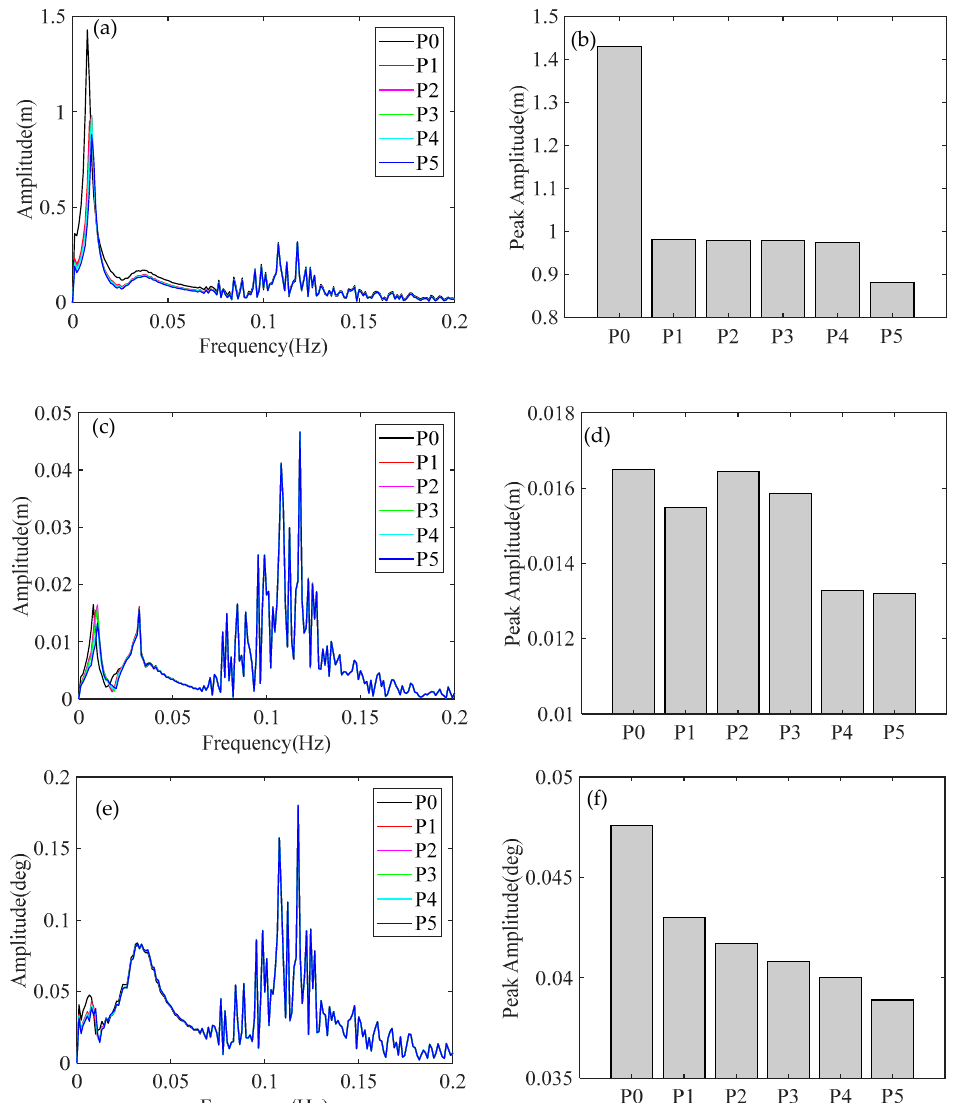
Figure 11. Frequency domain amplitude at load case 4 for ( a ) surge, ( c ) heave, and ( e ) pitch, and the peak amplitudes for ( b ) surge, ( d ) heave, and ( f ) pitch.